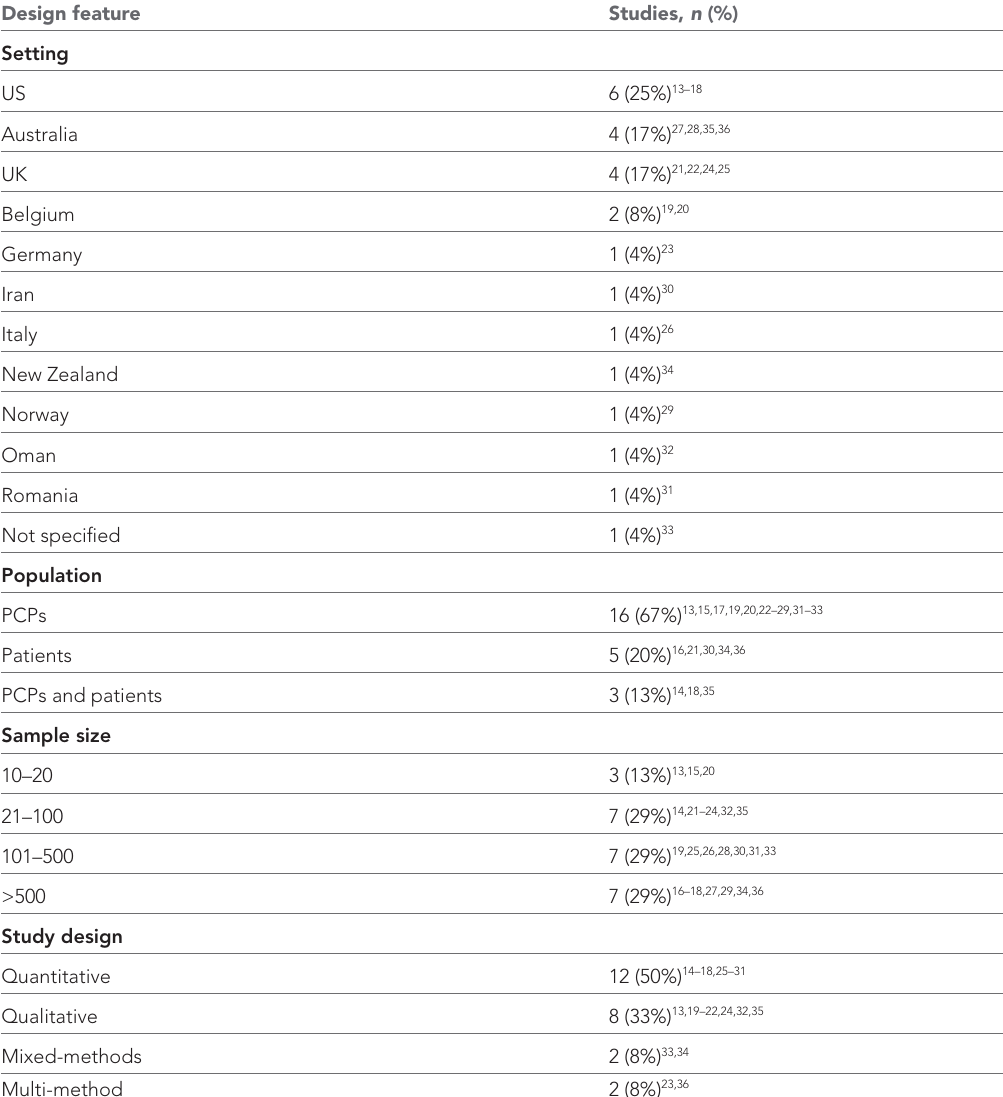
Table 2 Summary of characteristics of articles included in the review Design